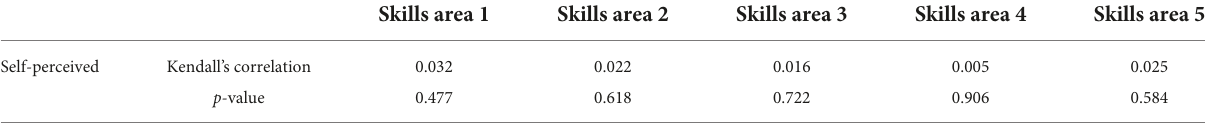
TABLE 10 Analysis of the correlation between self-perceived digital competence and the level of digital